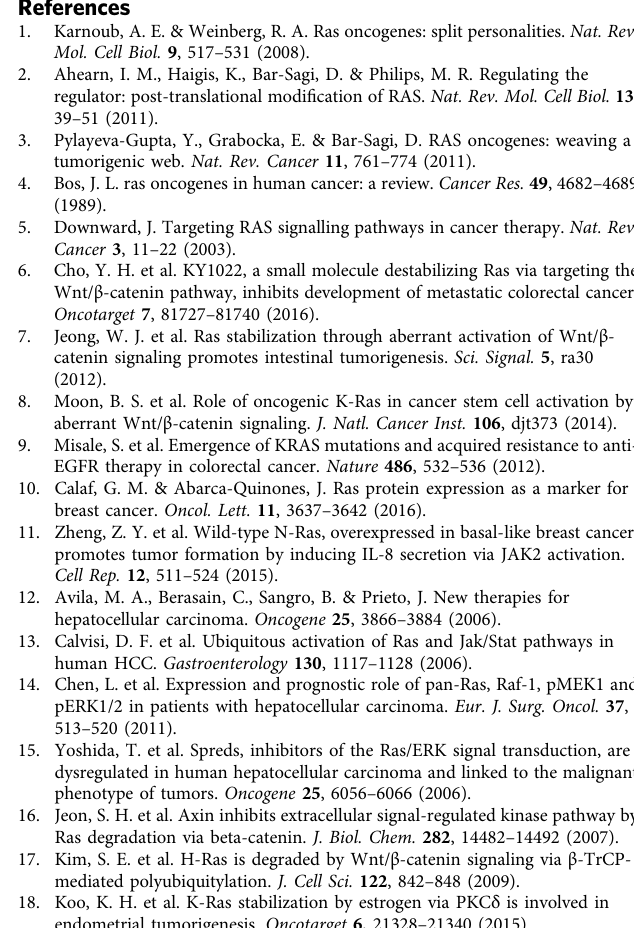
In situ hybridization . In situ hybridization was performed as previously descri- bed 44 . Paraformaldehyde- fi xed paraf fi n sections were deparaf fi nized and rehy- drated. Sections were then incubated in fi xation solution (4% PFA in PBS) at room temperature for 10 min. To remove protein, the sections were incubated in